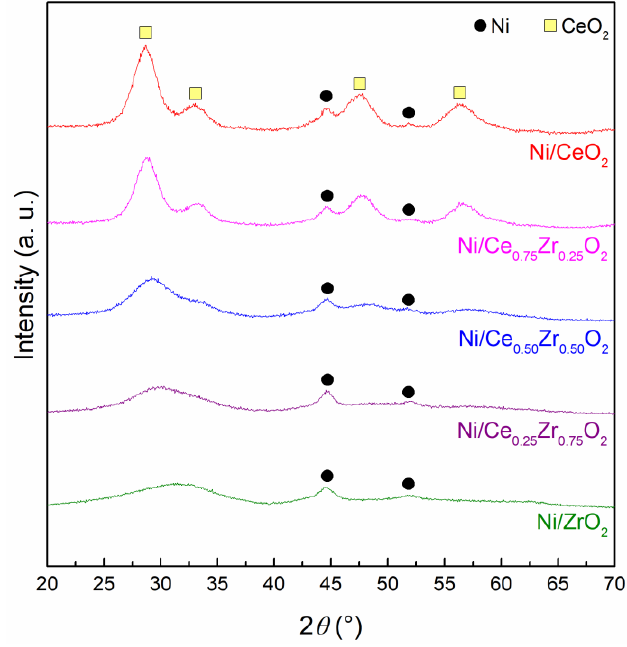
Figure 4. XRD patterns of the Ni/Ce x Zr 1- x O 2 samples.